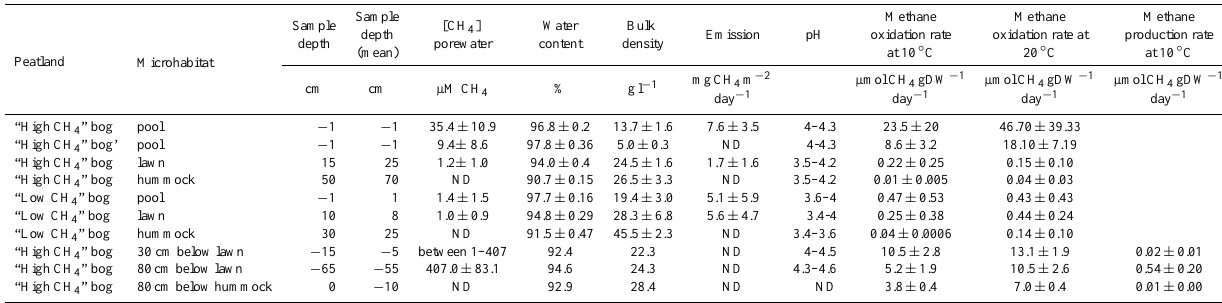
Table 1. Overview of ecological parameters obtained at the “high CH 4 ” bog and “low CH 4 ” bog. Sampling depths relative to water levels are positive when the sample was taken above the water level (living Spagnum moss) and negative when the sample was taken from below the water level (litter). Sample depths are indicated as measured at the day of sampling and relative to the mean summer water level. ND indicates no data. Water content is expressed in % of the wet